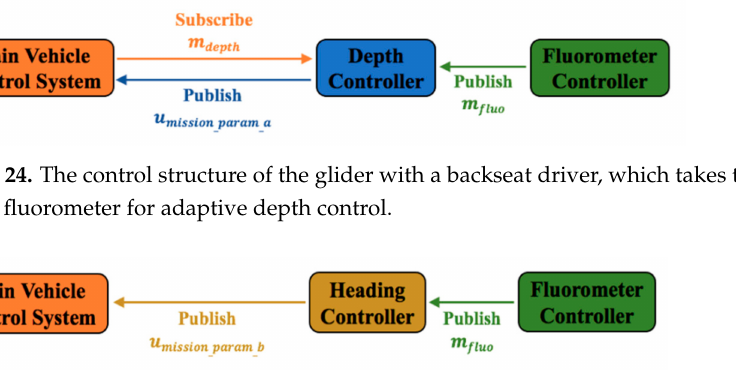
Figure 25. The control structure of the glider with a backseat driver, which takes the measurements from a fluorometer for adaptive heading